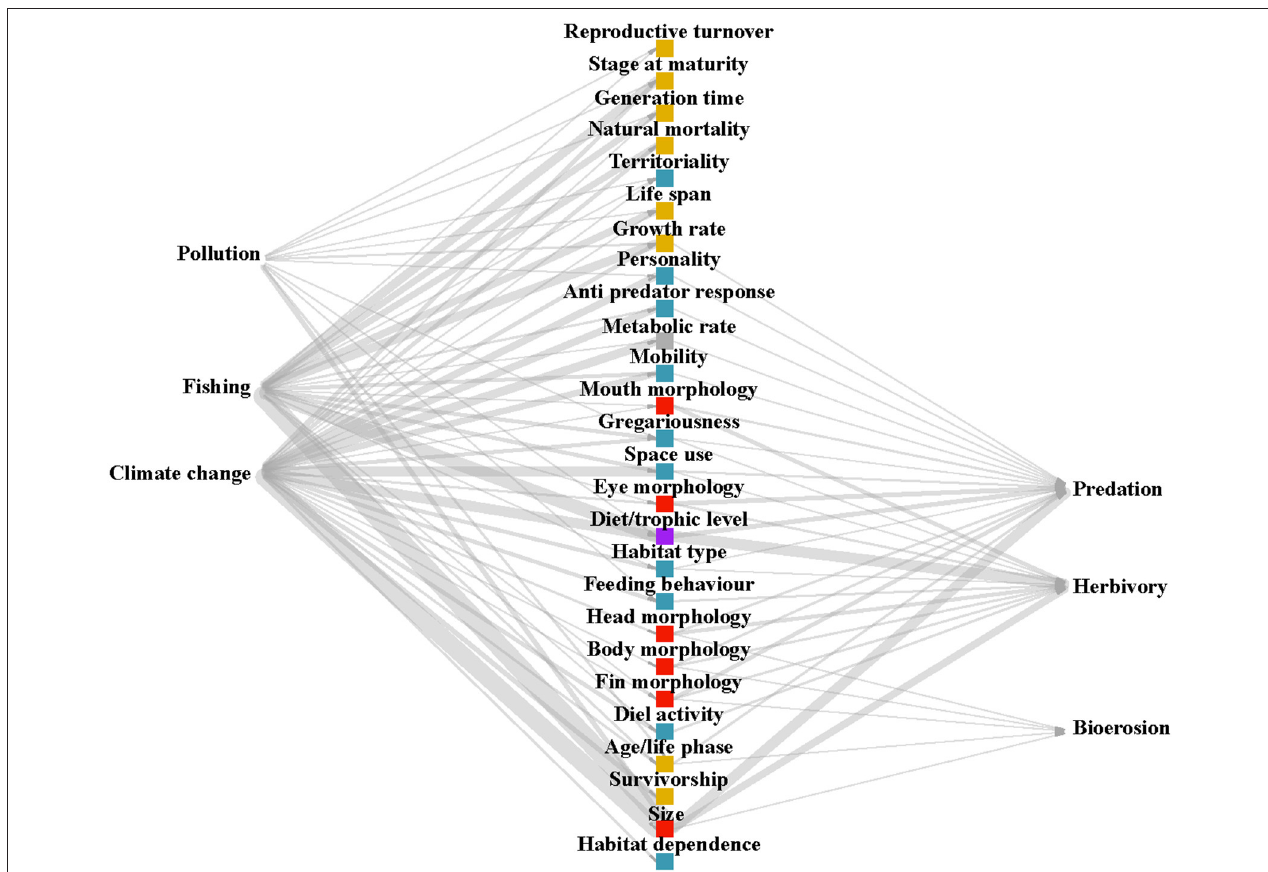
FIGURE 1 | Tripartite network diagram showing the number of papers linking each disturbance and process to response and effect traits. The color of trait points corresponds to broad trait groupings (blue: behavioral, yellow: life-history, red: morphological, gray: physiological, purple: diet).